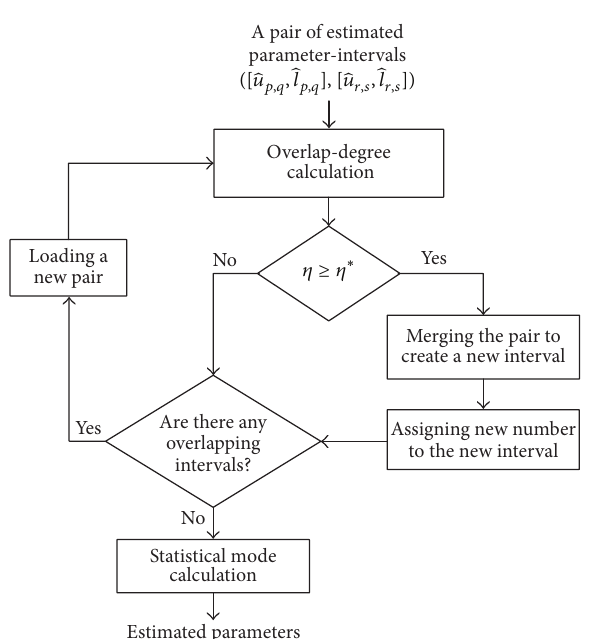
Figure 14: Averaging algorithm used in the automatic parameter